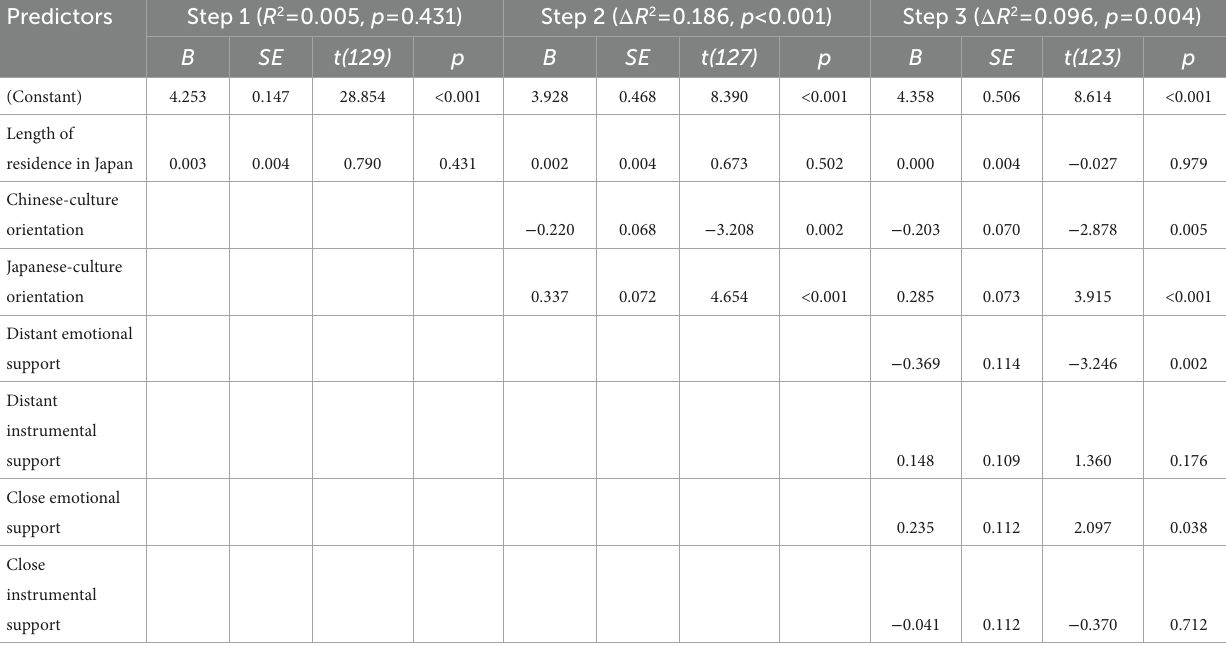
Unstandardized regression coefficients are presented.